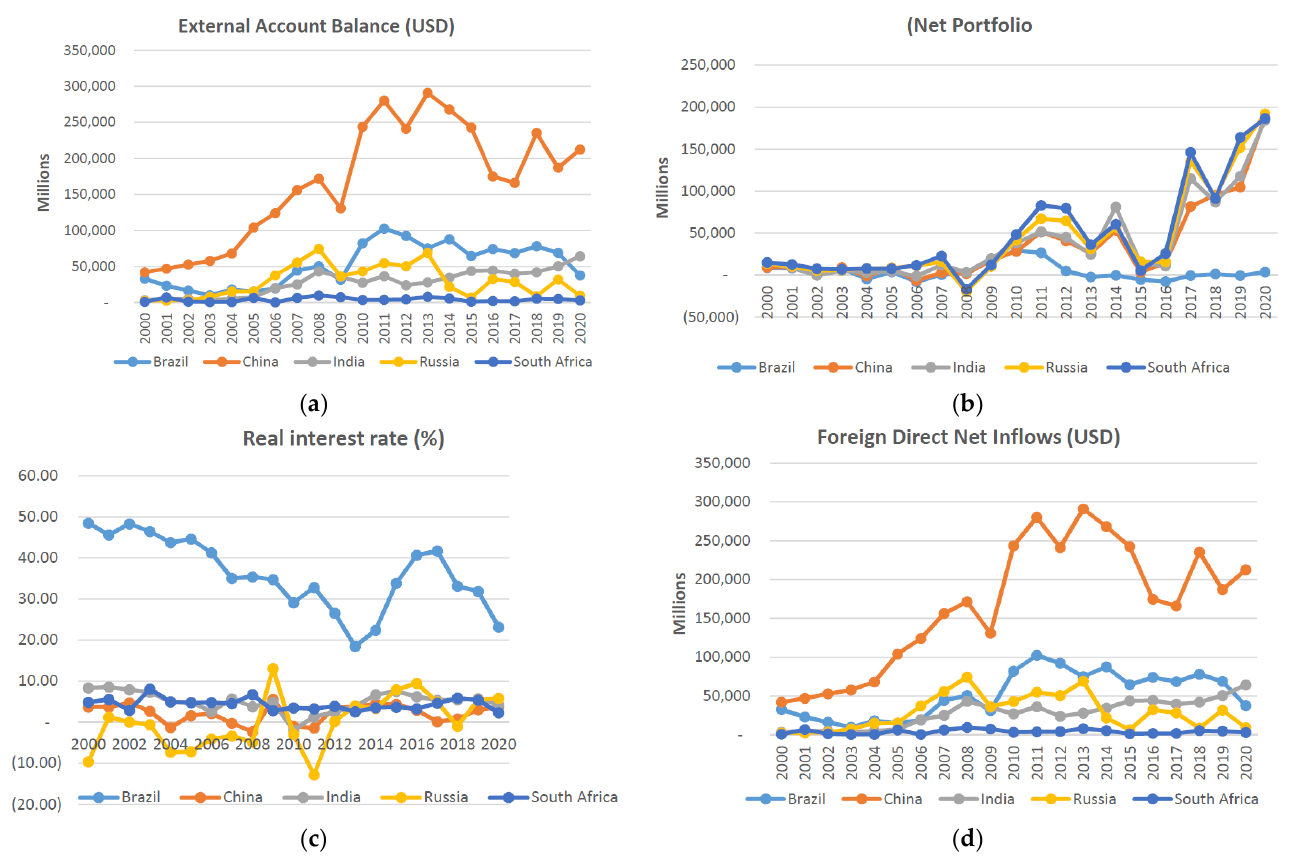
Figure 1. Macroeconomic variables. ( a ) external account balance; ( b ) Net portfolio investment inflows—bonds; ( c ) Interest rate spreads; ( d ) foreign direct investment inflows (USA’bn).